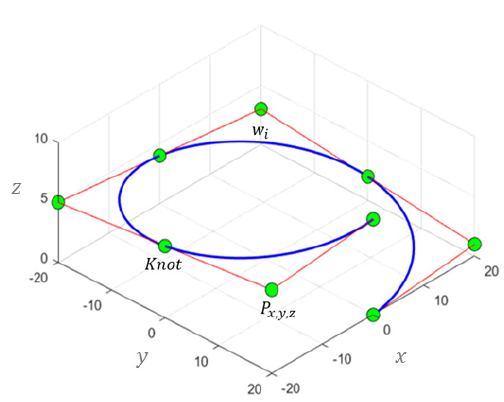
Figure 1. Representation of nonuniform-rational-basis-spline (NURBS) curves coupled in 3D space.